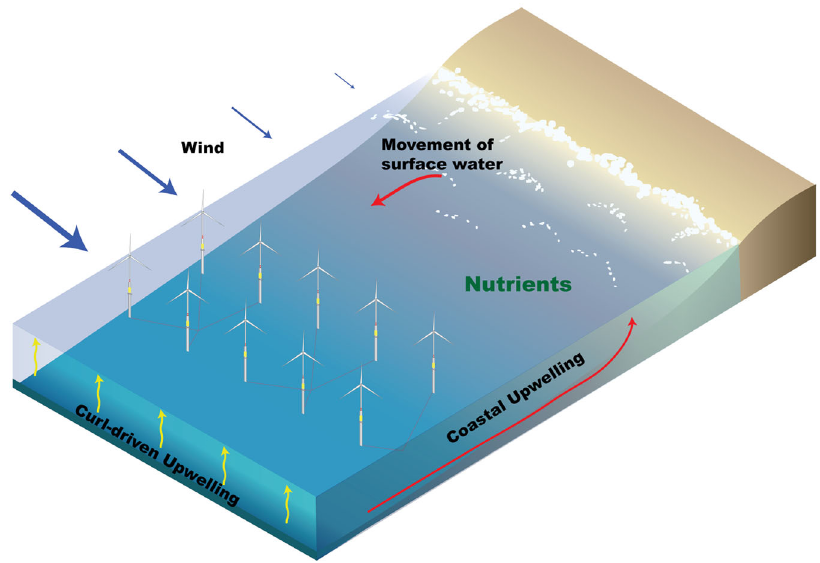
Fig. 1 Schematic of upwelling processes near an eastern ocean boundary. Coastal upwelling occurs in a narrow (10 – 20 km) coastal band and curl-driven upwelling over a larger offshore area. Figure adapted from Raghukumar et al. (2022) 16